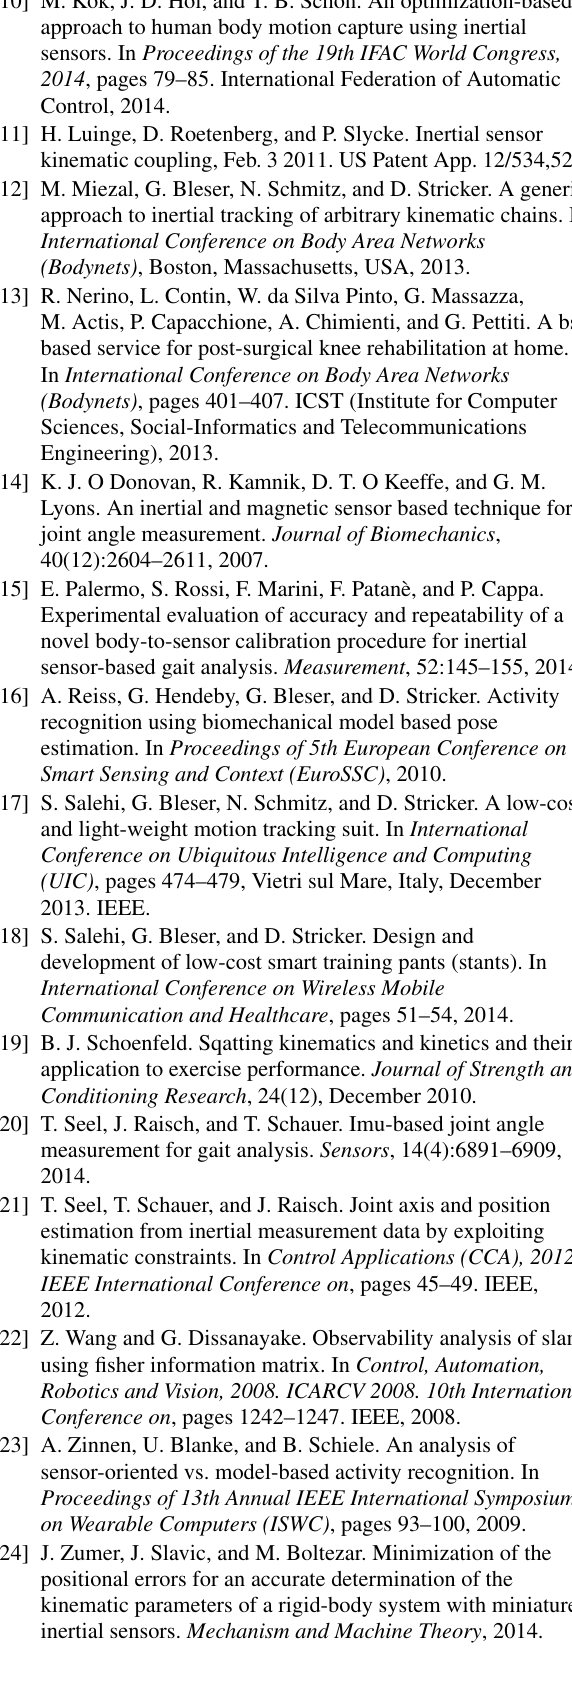
tations and the quasi-constant IMU positions with respect to the adjacent